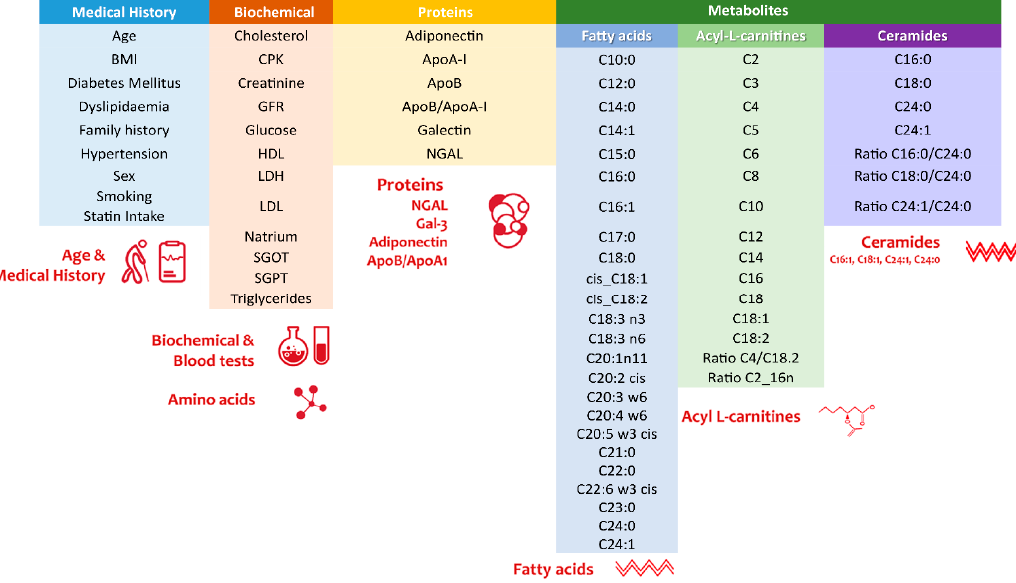
Figure 2. The 73 parameters that constitute the CorLipid algorithm input biomarker panel. ApoAI: apolipoprotein AI, ApoB: apolipoprotein B, NGAL: neutrophil gelatinase-associated lipocalin, Gal-3: galectin-3.